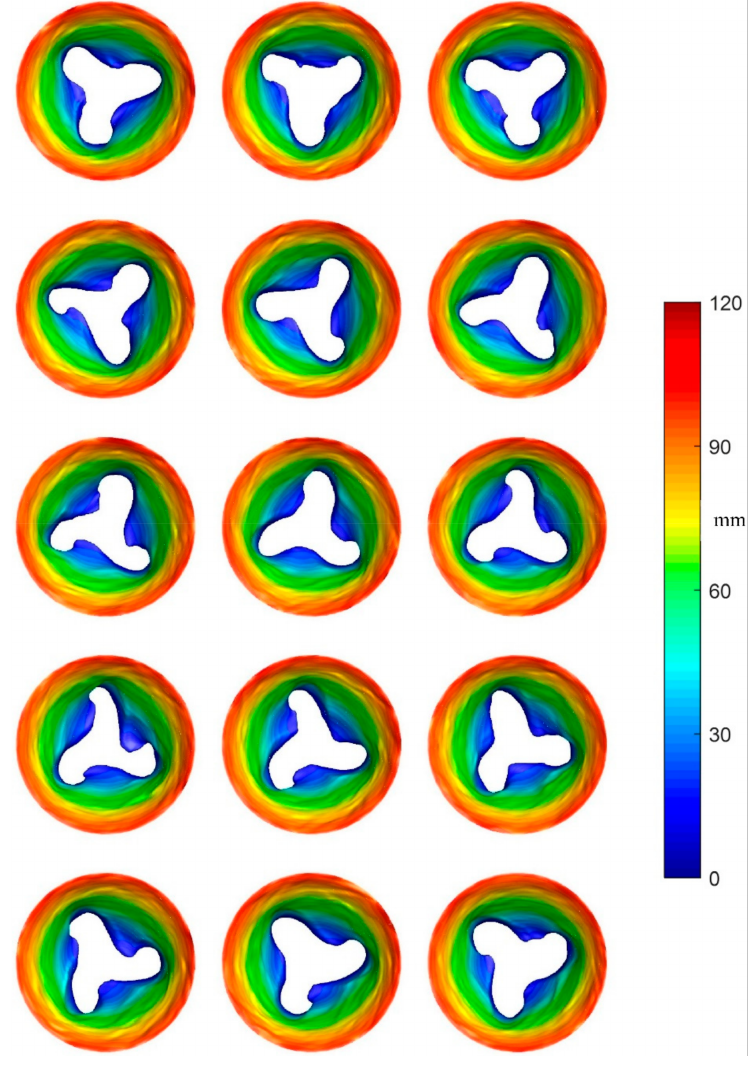
Figure 5. Top view contours of the free surface height above rotating disk for its rotation frequency of 4.6 Hz, from top left to bottom right, equally spaced within 14 s of